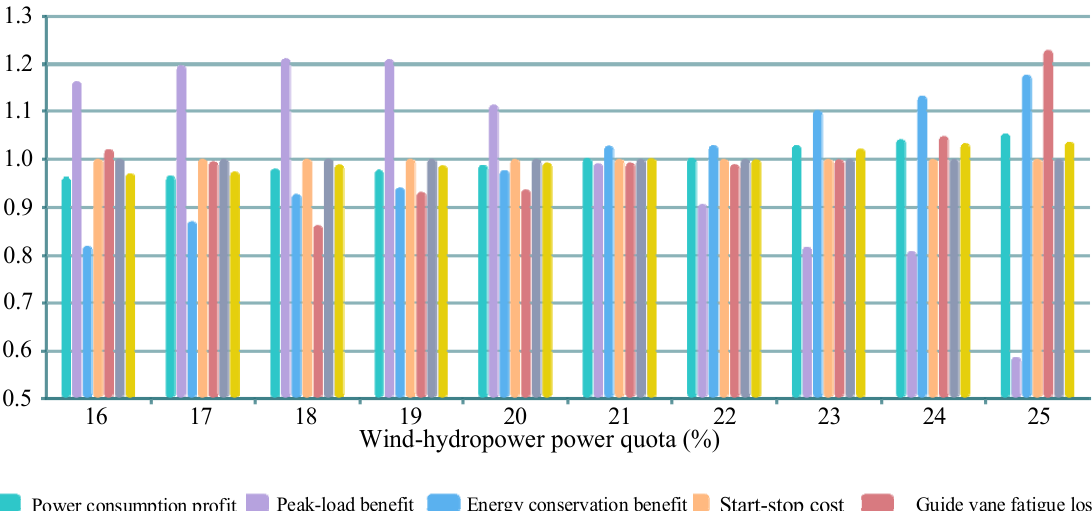
Figure 14. Comprehensive regulation benefit of wind–hydropower renewable energy in improving the utilization of coal-fired generation. Y -axis uses the relative value of the quantified profit/cost to represent the volatility coefficient, and the relative value is equal to the ratio between the actual value and base line value. The “P.u.” is short for the profit/cost unit, and “%” is short for the unit of energy quota.